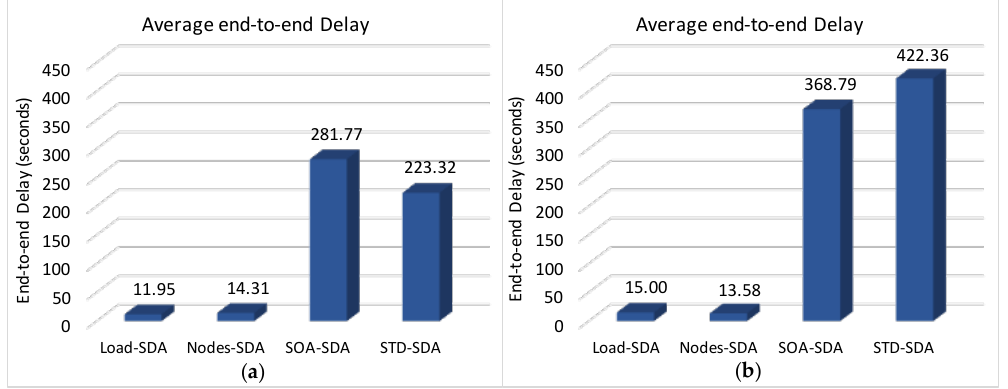
Figure 19. Average end-to-end communication delay for a network with a longer Beacon Interval in the: ( a ) Unconditioned Scenario; ( b ) Conditioned